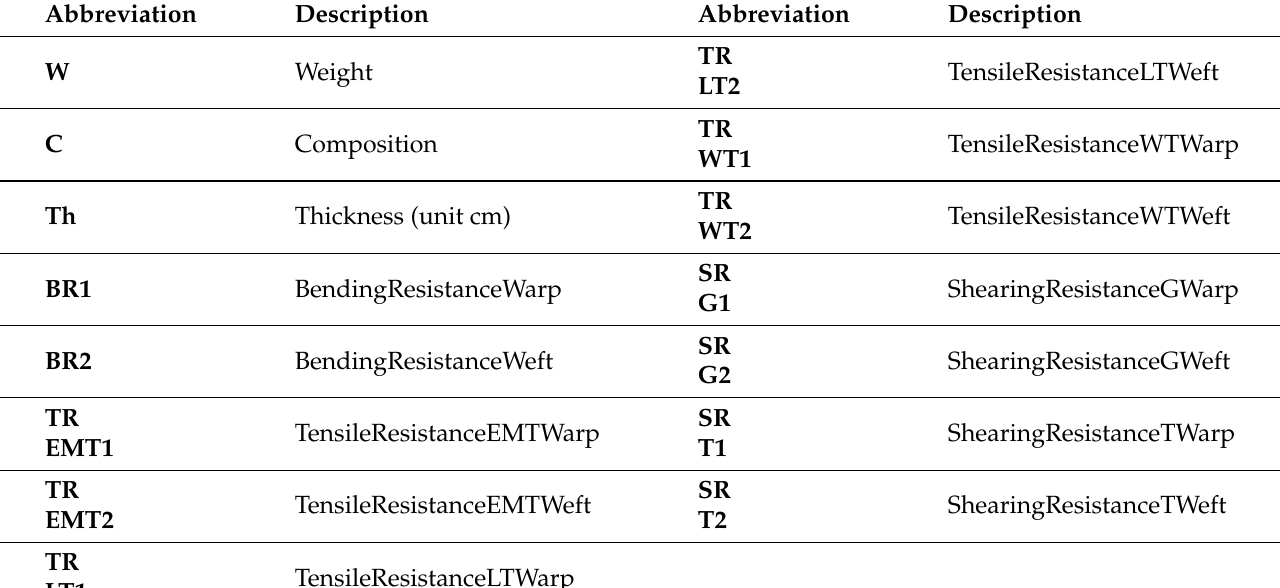
Table 11. Fabric properties description table for Tables 9 and